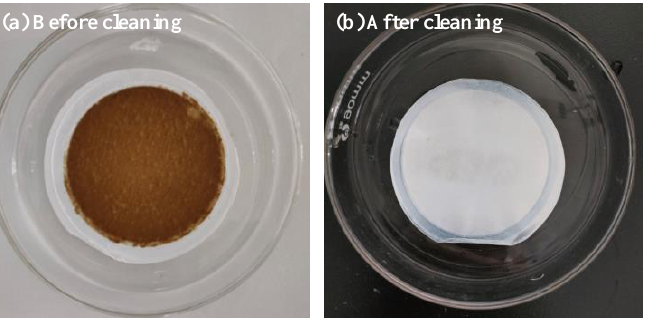
13 of 22 Figure 6. Using the ENM-14 specimen: ( a ) Average water fluxes ( J av ), average EPS recovery rates ( η av ), and ( b ) filtration behaviors in the dead-end filtration of a 1.0 g/L EPS solution at various filtra- tion pressures ( p = 20, 40, 60, 80, and 100 kPa). The evaluated data were obtained for the cumulative filtrate volume per unit membrane area, v = 2 cm. The horizontal axis shows v , while the vertical axis shows the reciprocal of the filtration rate (d θ /d v ), and θ is the filtration time. 3.4. Fouling and Reusability of the ENMs in the Filtration of EPSs The prevention of membrane fouling is a key factor in the development of new mem- brane technologies. It is worth emphasizing that the EPSs used in this study were ex- tracted from the excess sludge sample via CER, which is able to efficiently recover the EPSs because of little destruction of microbial cells in the excess sludge [7,10]. Therefore, the EPSs can be considered as mixed water-soluble polymers, and it was found that an